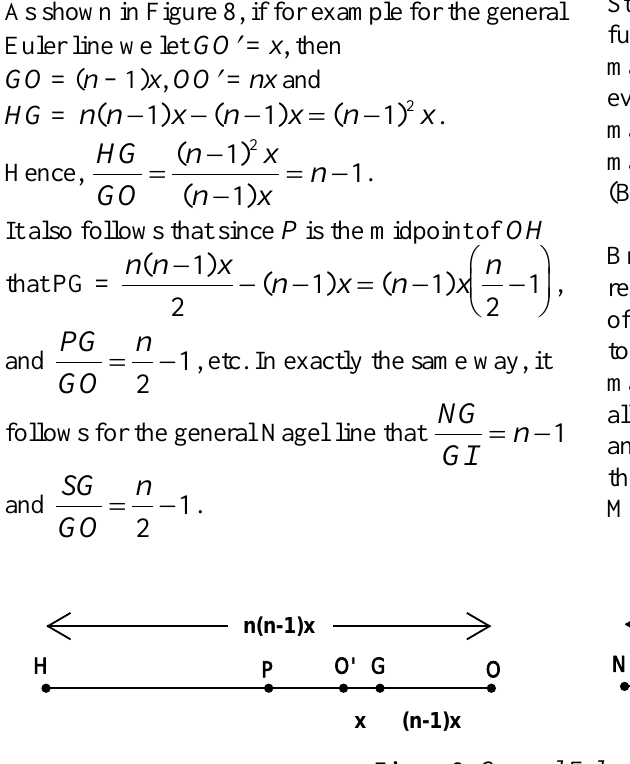
Figure 8: General Euler and Nagel